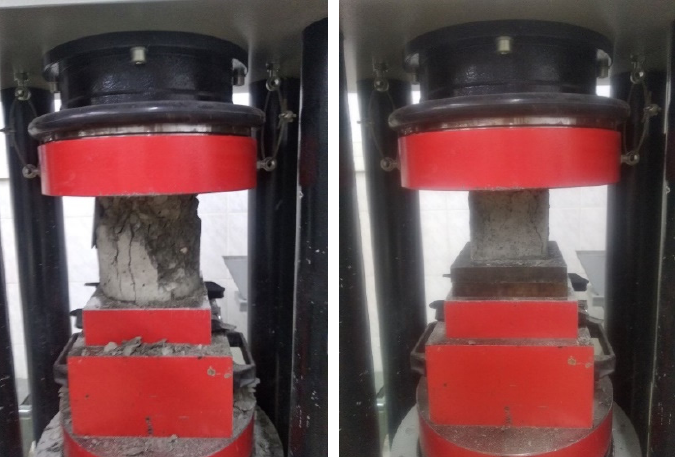
Figure 2. Compression test of cylindrical and cubic samples on the 1st, 3rd, 7th, 14th and 28th days.